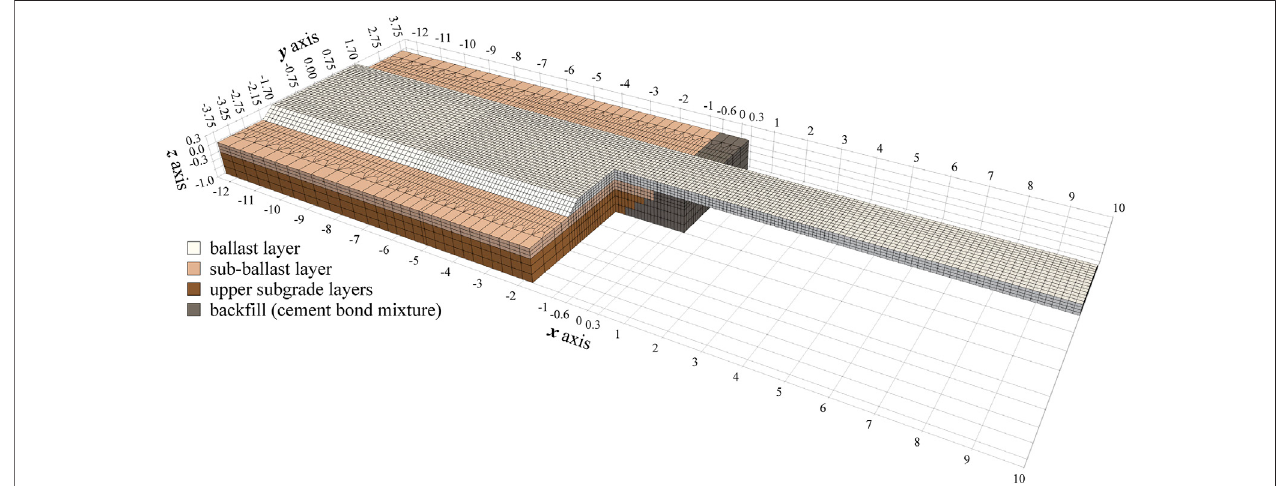
FIGURE 3 | Tridimensional view of the transition zone model showing fi nite element mesh and the axis grid (dimensions in m).